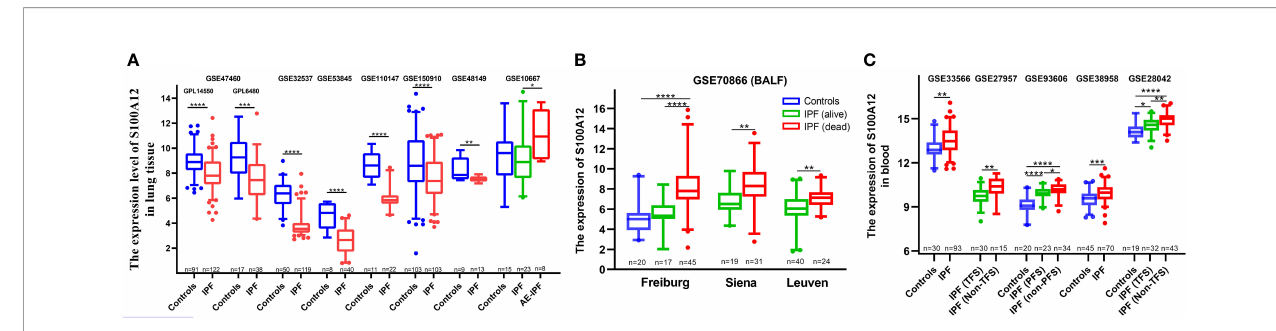
FIGURE 2 | Expression of S100A12 of lung tissue, BALF and blood in patients with IPF. (A) The expression of S100A12 in human lung. (B) The expression of S100A12 in the BALF. (C) The expression of S100A12 in the blood. P-values were showed as: *P < 0.05; **P < 0.01; ***P < 0.001; ****P <